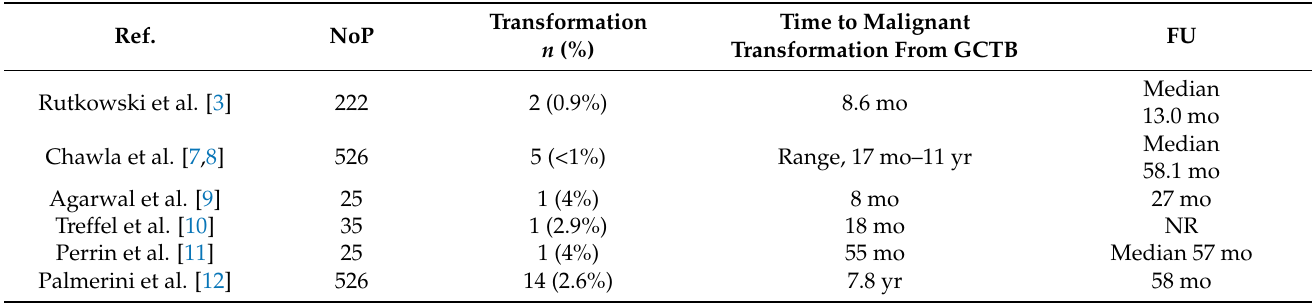
Table 2. Extracted data from patients reporting malignant transformation following